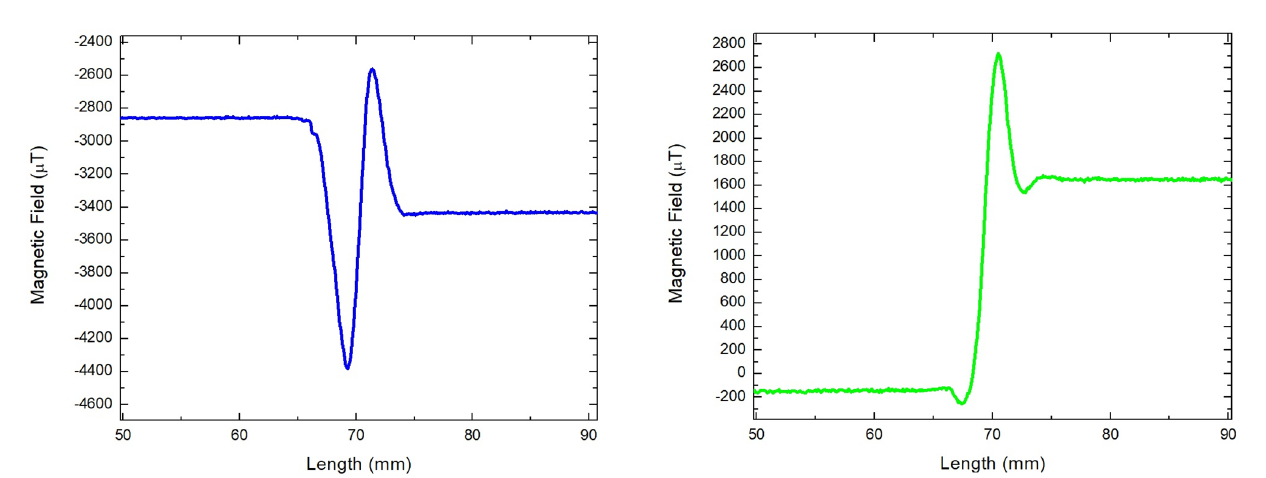
Fig. 19 Experimental result of magnetic field X of a rectangular defect C1 with ordered magnetic domains